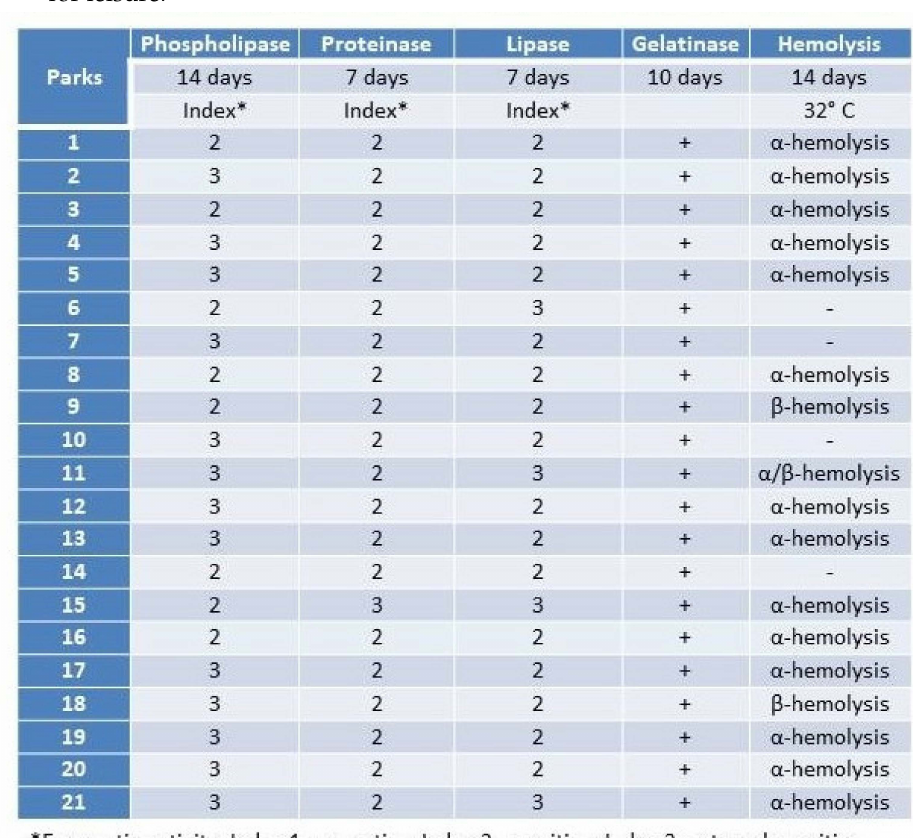
Figure 1. Production of phospholipase, proteinase, lipase, gelatinase, and hemolysins by Nannizzia gypsea strains isolated from the soil of parks in Sao